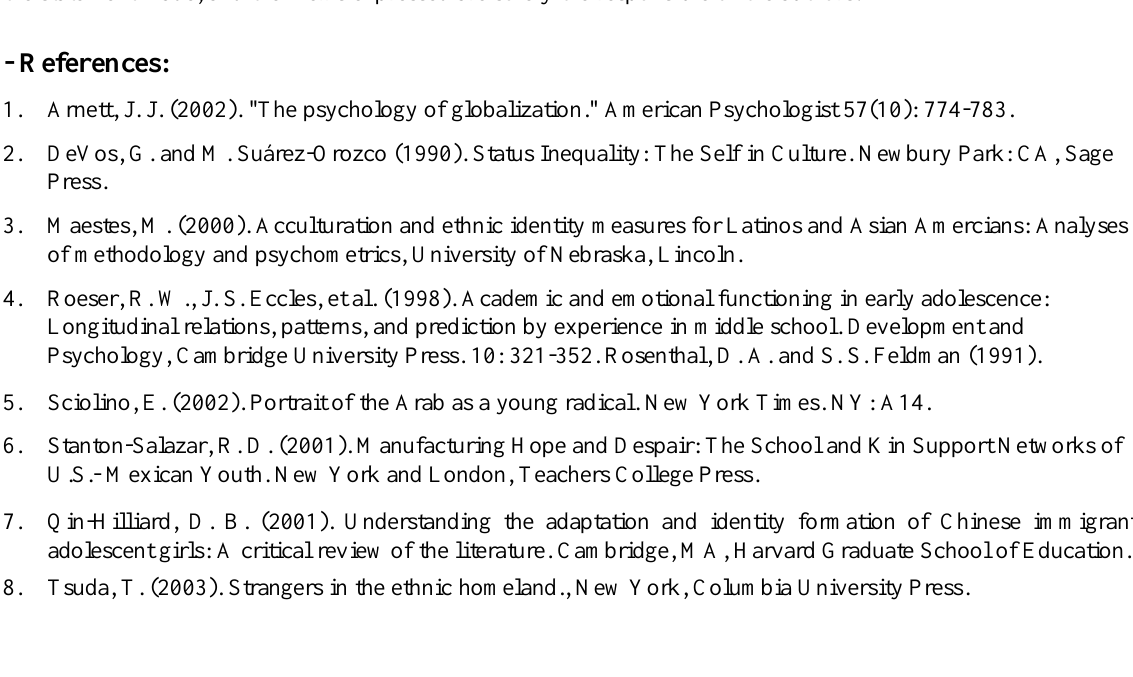
Source: Done by the